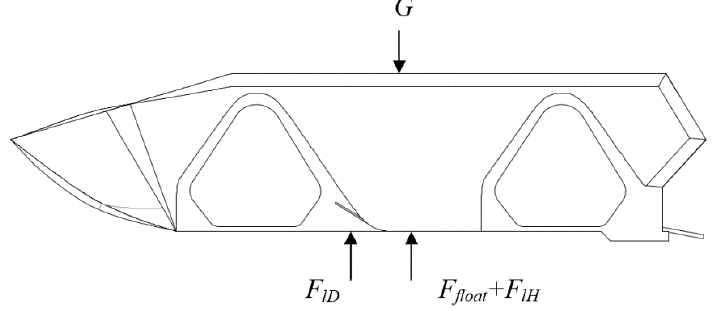
Figure 2. Equilibrium relation of HSAV weight.